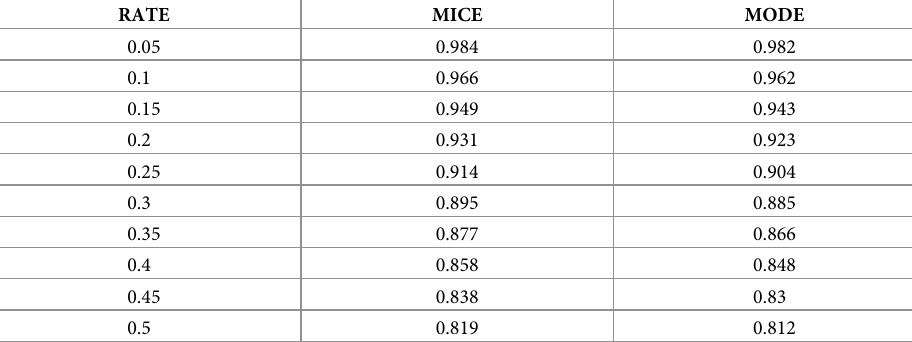
Table 4. The overall accuracy of MICE and mode. RATE MICE